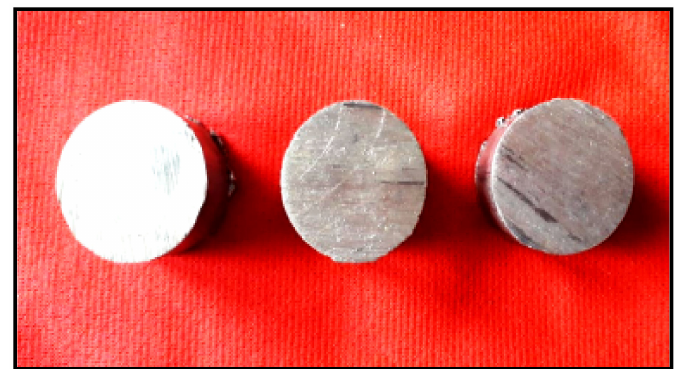
Figure 6. Photographic view of microhardness specimens.